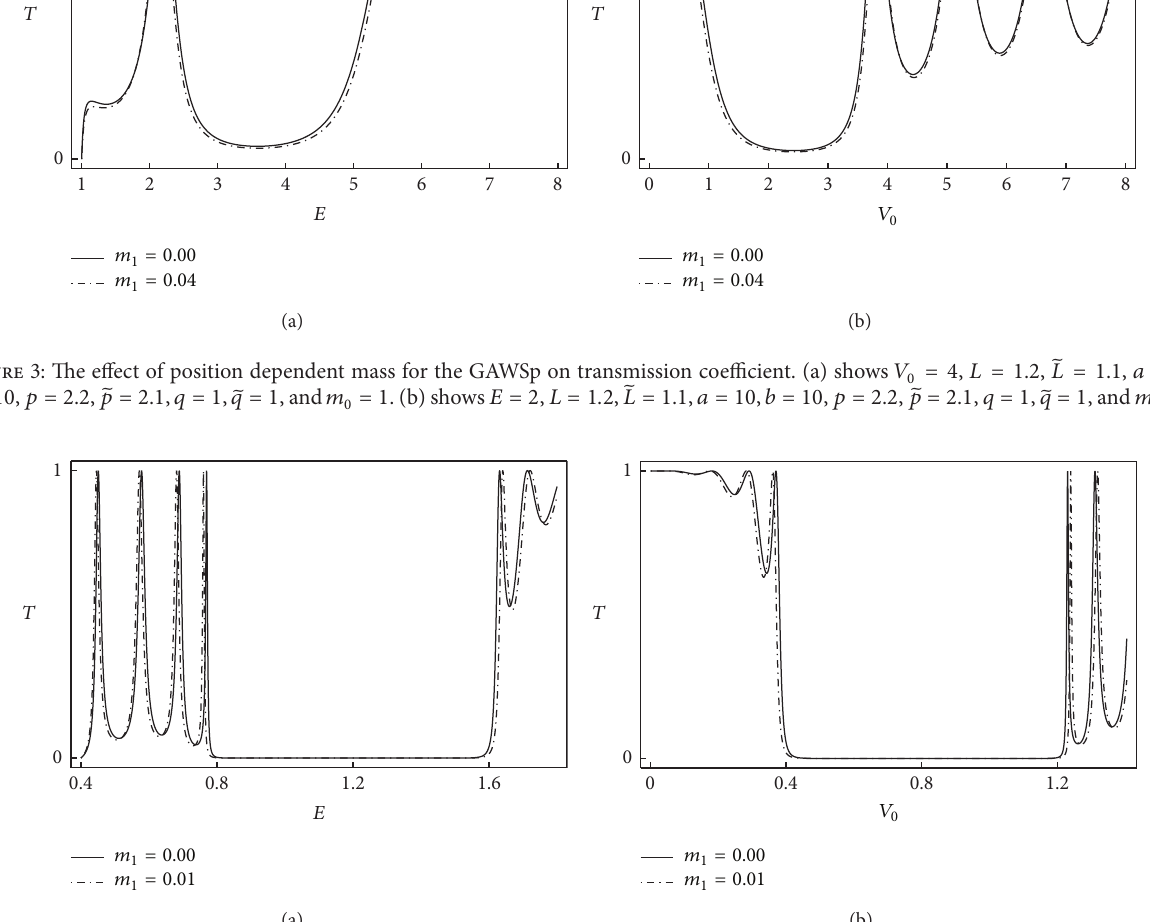
̃𝐿 = 10 , 𝑎 = 3 , 𝑏 = 3 , 𝑝 = 1 , ̃𝑝 = 1 , 𝑞 = 1 , ̃𝑞 = 1 , and